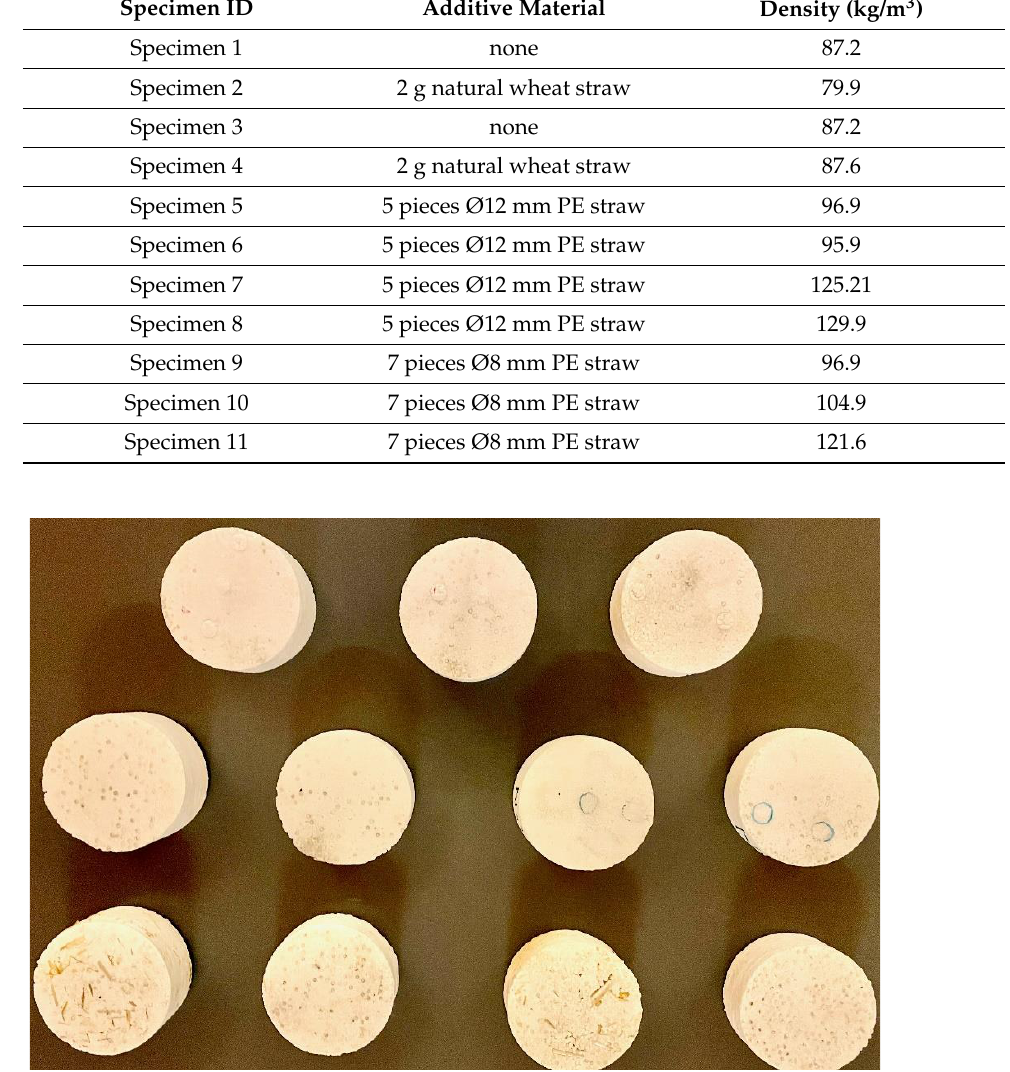
Figure 5. Sample pieces (numbering from the upper left corner).